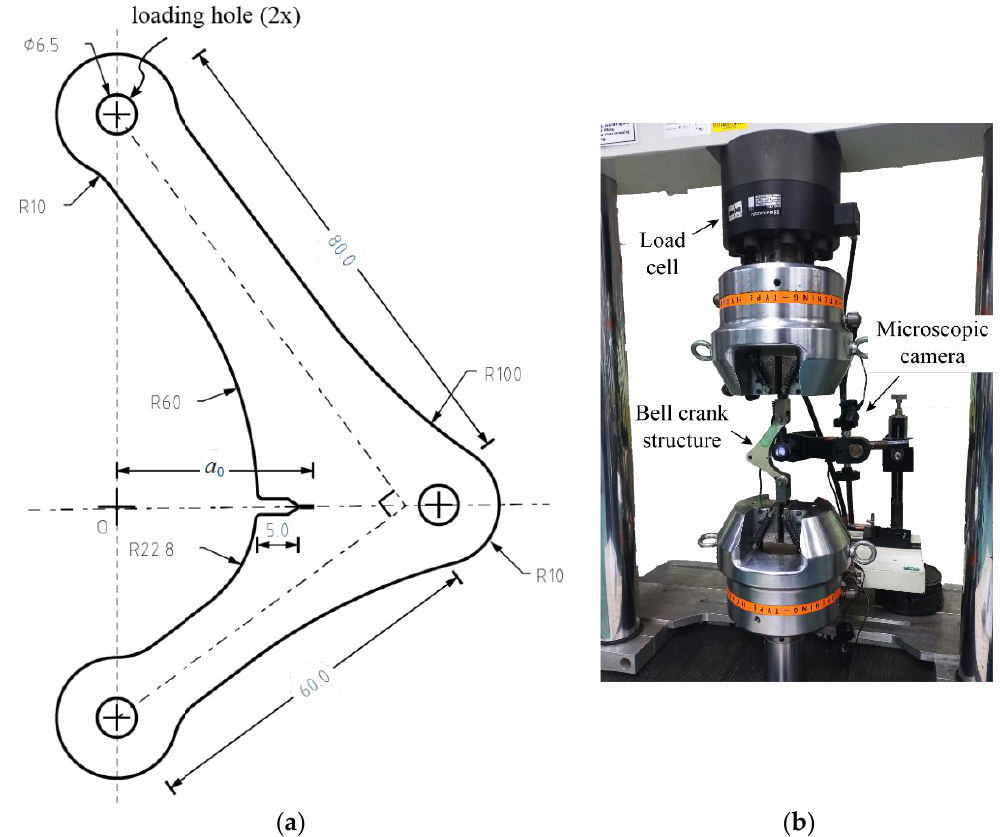
Figure 2. Testing of the bell crank structure. ( a ) Geometry and dimensions (in mm) of the L-shaped bell crank structure. Thickness is 20 mm. ( b ) Experimental setup of the fatigue crack growth test of the bell crank structure.